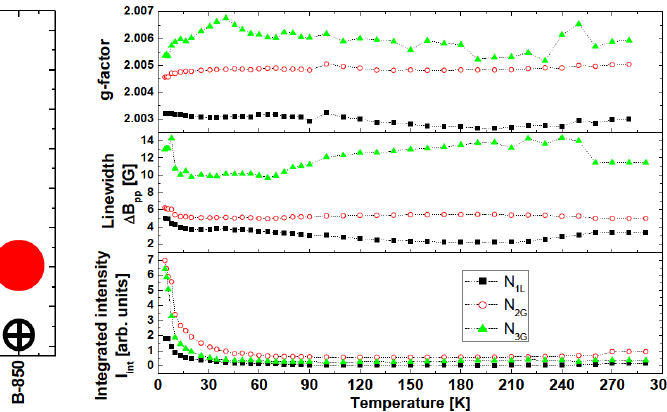
Figure 20: The g -factors of three subcomponents of the N compo- nent line in all investigated samples measured at RT. For samples calcined at temperature 650 ∘ C and lower three subcomponents were needed, for samples calcined at 700 ∘ C and higher two sub- components were suflcient. The size of used symbols is propor- tional to the square root of the integrated intensity of a specific subcomponent.